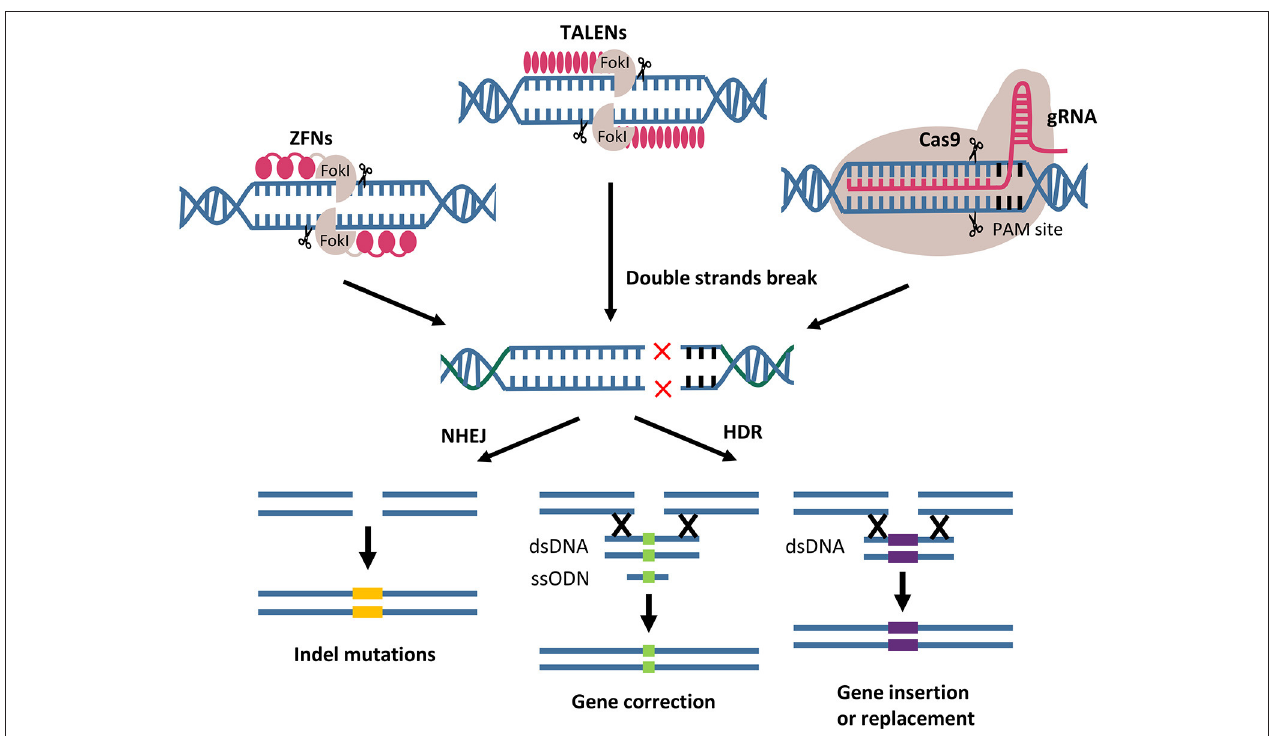
FIGURE 4 | Gene editing by designer nucleases. ZFNs, TALENs, and CRISPR/Cas9 mediated the genome modifications through two main double strand break repair pathways. Indel mutations resulted from NHEJ pathway. Gene correction, insertion and replacement using DNA donor template are the outcomes of HDR pathway. FokI, endonuclease from Flavobacterium okeanokoites ; PAMs, protospacer adjacent motifs; NHEJ, non-homologous end joining; HDR, homology-directed repair; dsDNA, double-stranded DNA; ssODN, single strand